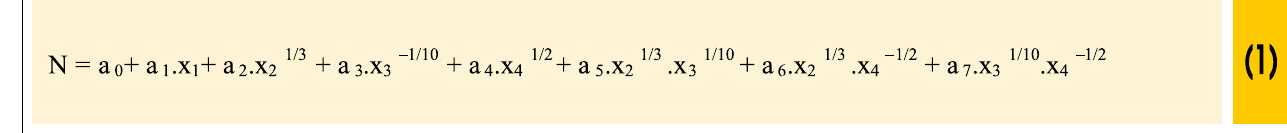
tions. The following variables were used: the normalized income of the area, the normalized elevation and distance from the sea and the relative position of the building considering the north coast and the All Saints Bay. After several attempts at using different types of functions, equation 1 was selected to reproduce the data obtained in the field. It is a highly nonlinear empirical function, and the validity of the obtained fitting coefficients are restricted to the area